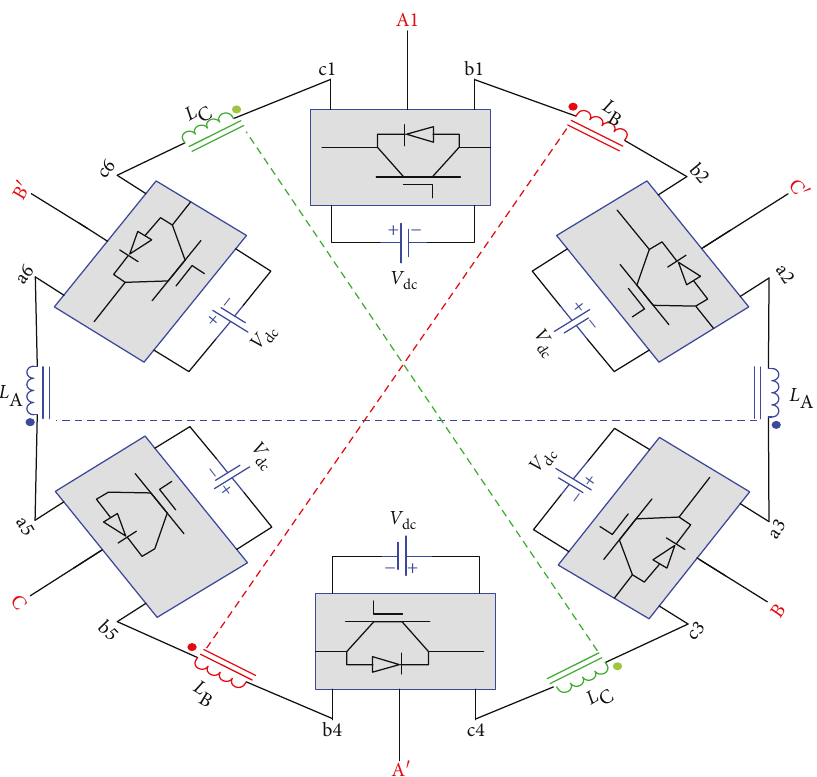
Figure 10: The HMC with three two-winding coupled